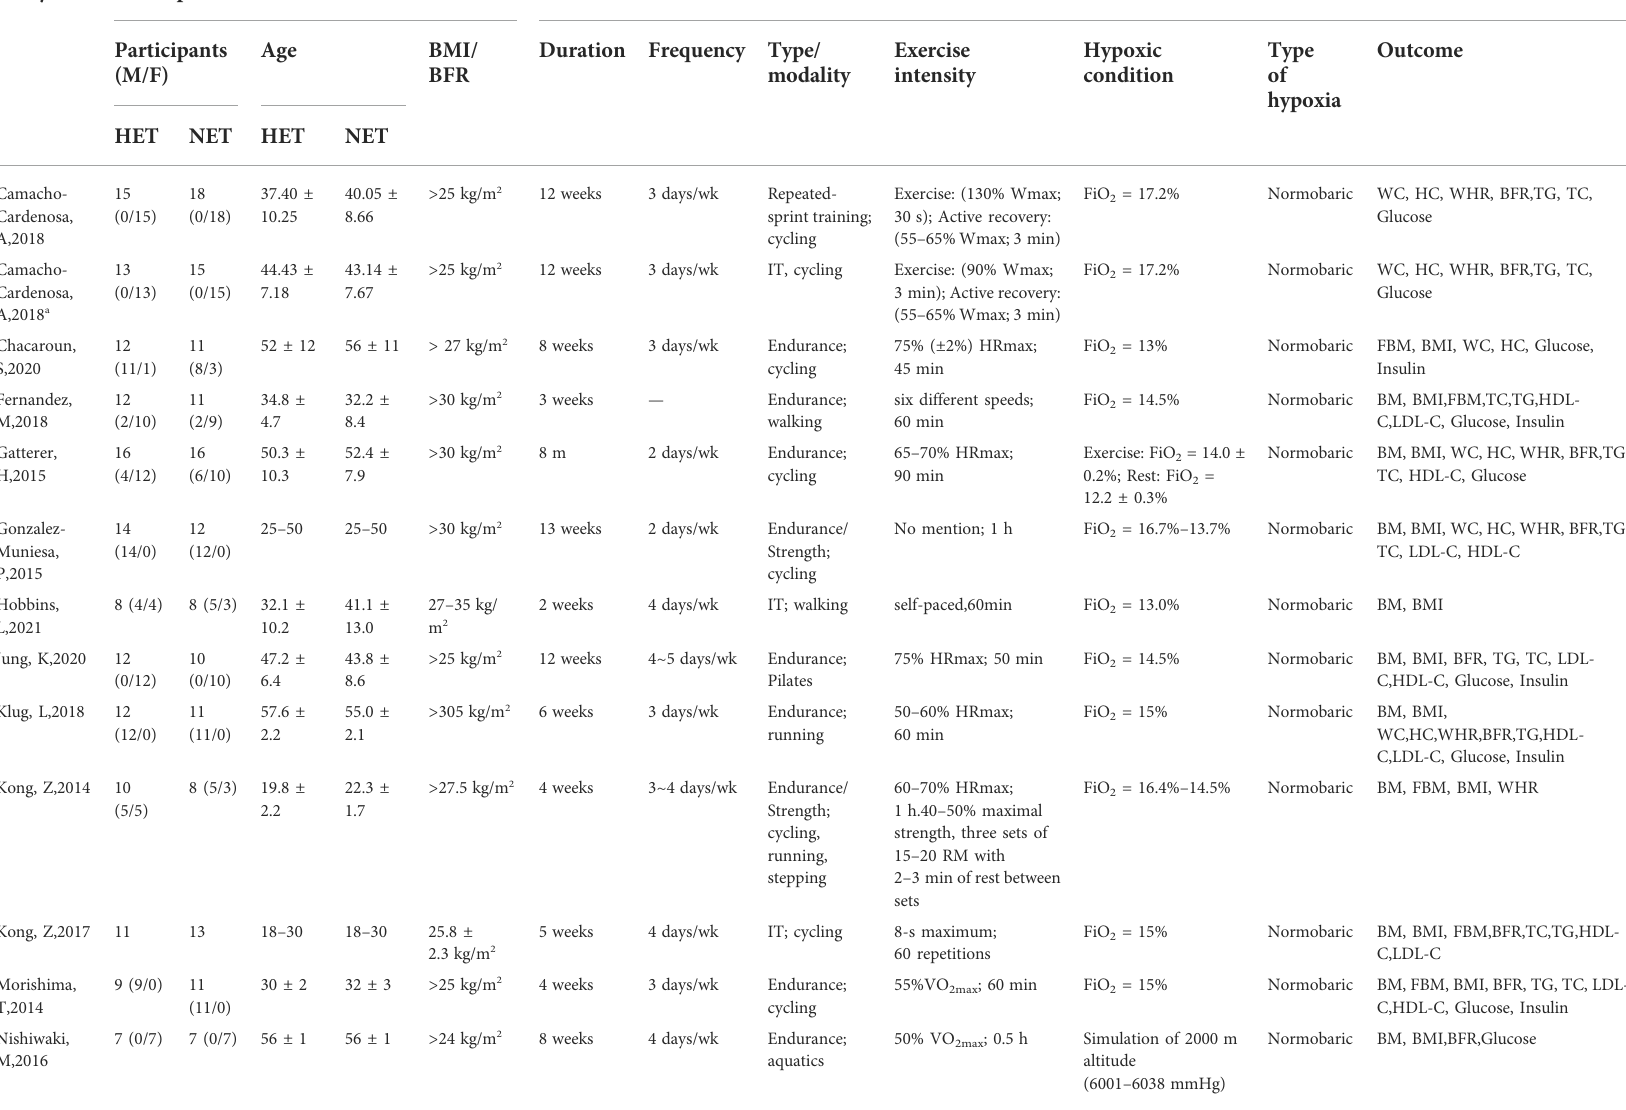
TABLE 1 Main characteristics of studies included in the